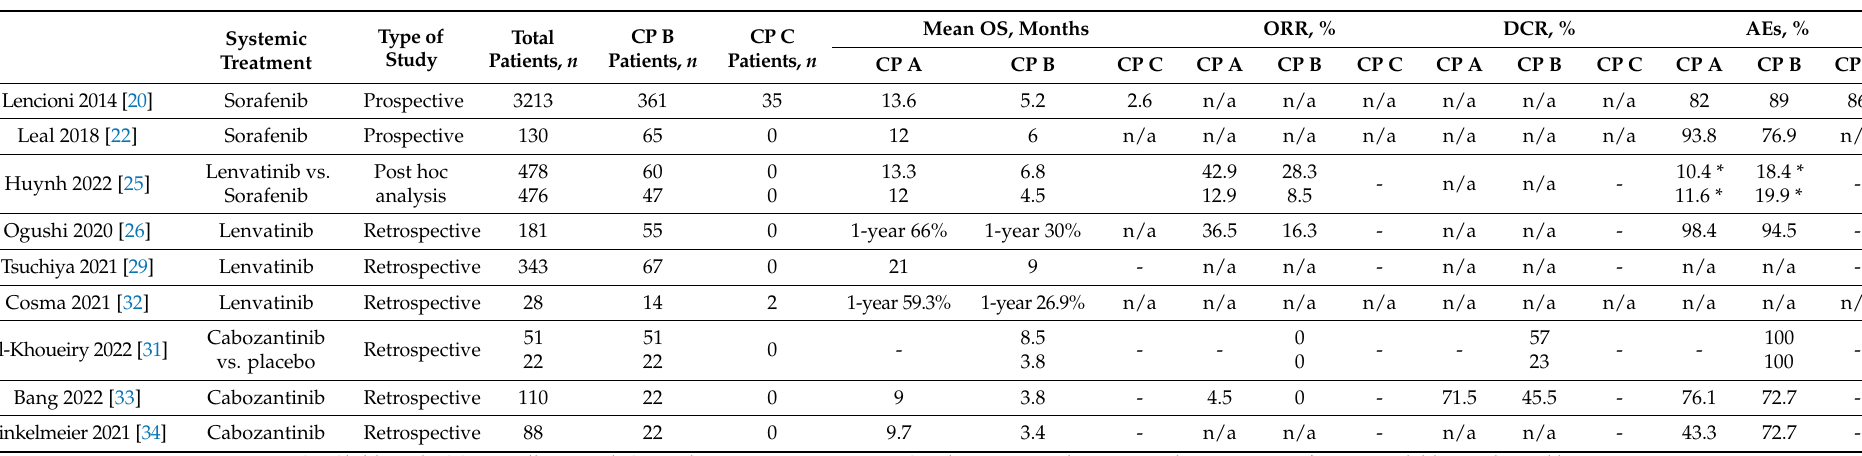
Table 1. Studies examining the efficacy and safety of Multikinase Inhibitors (MKIs) in patients with decompensated cirrhosis and hepatocellular